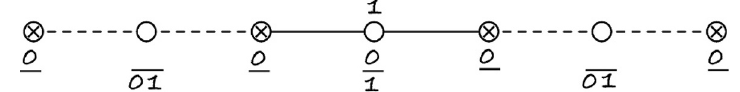
Figure 2 . Dynkin diagram of psu (2 , 2 | 4) in the alternating grading. Numbers in the lower row represent Baxter functions in the overlap formula, according to the conventions of figure